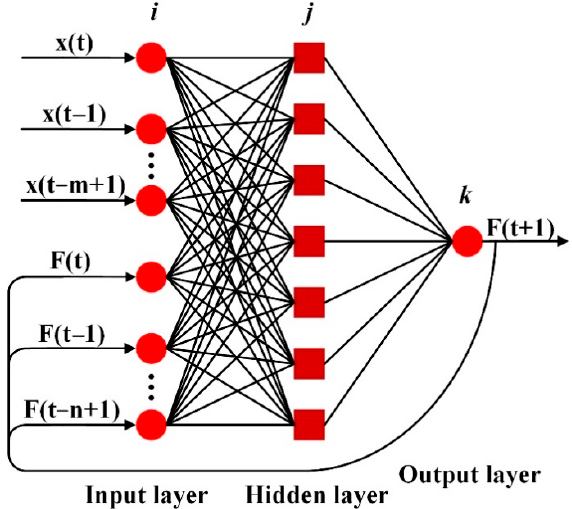
Figure 9. Schematic diagram of the neural network ANN2 structure, part of the BPNN-PID controller depicted in Figure 6.